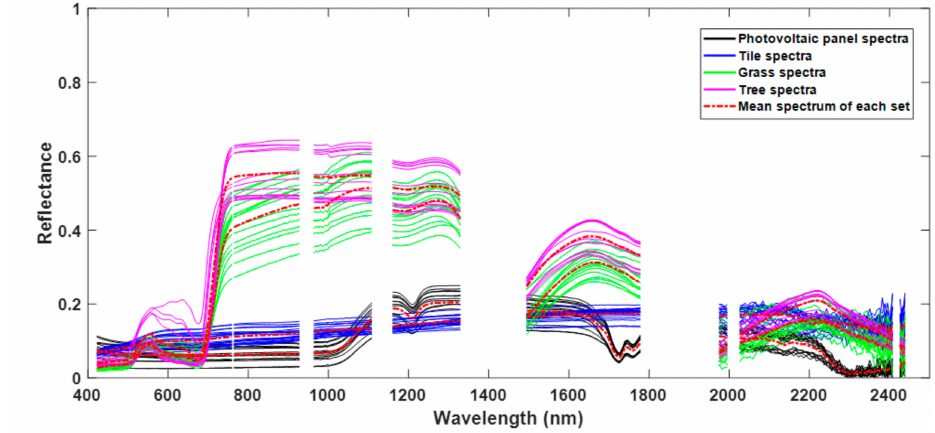
Figure 1. The four sets of urban environment spectra, and their means, used for creating the realistic synthetic hyperspectral data (the gaps correspond to the removed atmospheric absorption spectral